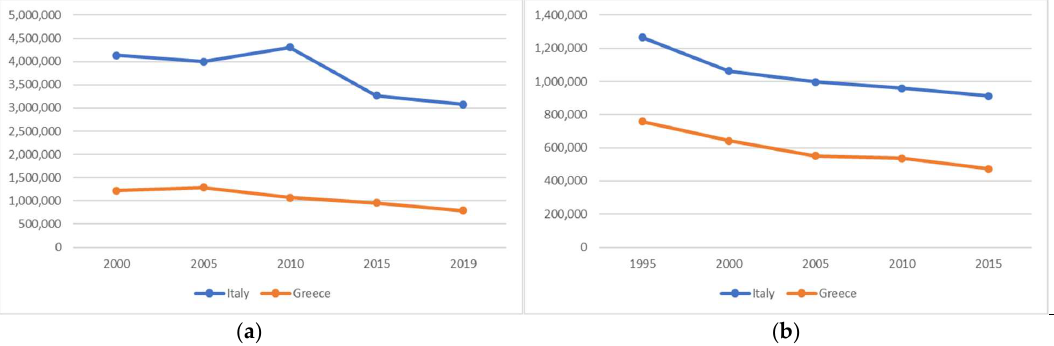
Figure 1. Reduction of agricultural cultivated area (in ha): ( a ) 2000–2019 and agricultural jobs; ( b ) 1995–2015 [26]) in Italy and Greece.